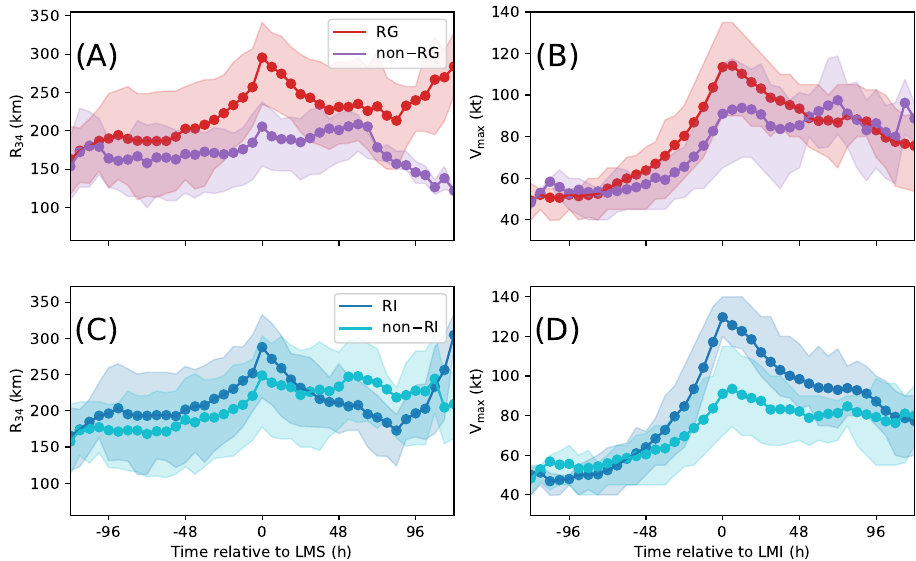
Figure 6. Composite of the evolution of ( A ) R 34 and ( B ) V max for the RG and non-RG TCs. ( C ) and ( D ) are the same with ( A ) and ( B ), but for the RI and non-RI TCs. The solid lines represent the average values, while the shadows represent one standard deviation.